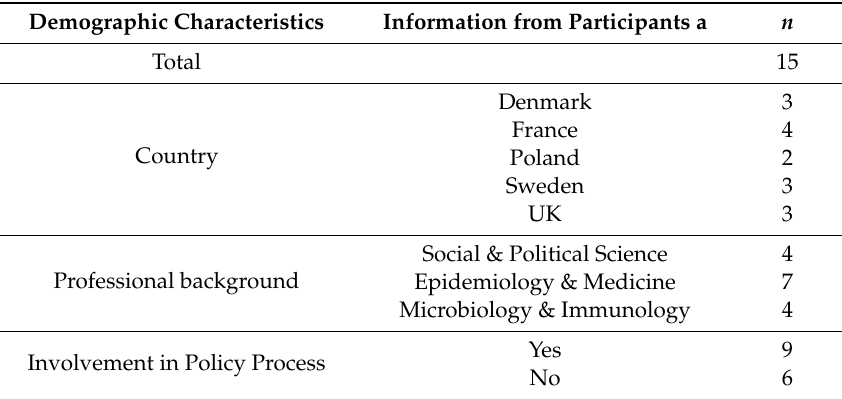
Table 2. Demographic characteristics of